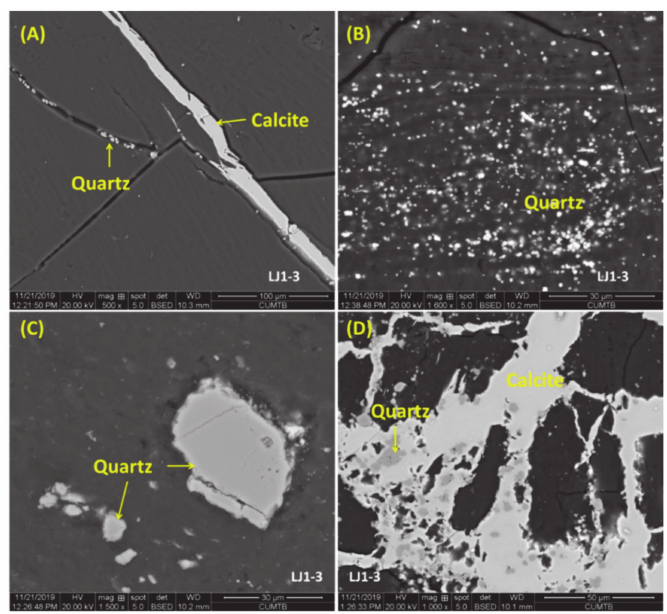
Figure 3. SEM backscattered electrons images of quartz and calcite in C1 coals of Liangjia Coal Mine. ( A , B ) Fine quartz particles in cracks or scattered in the organic matter; ( C ) quartz of detrital origin; ( D ) fracture-filling quartz and calcite.